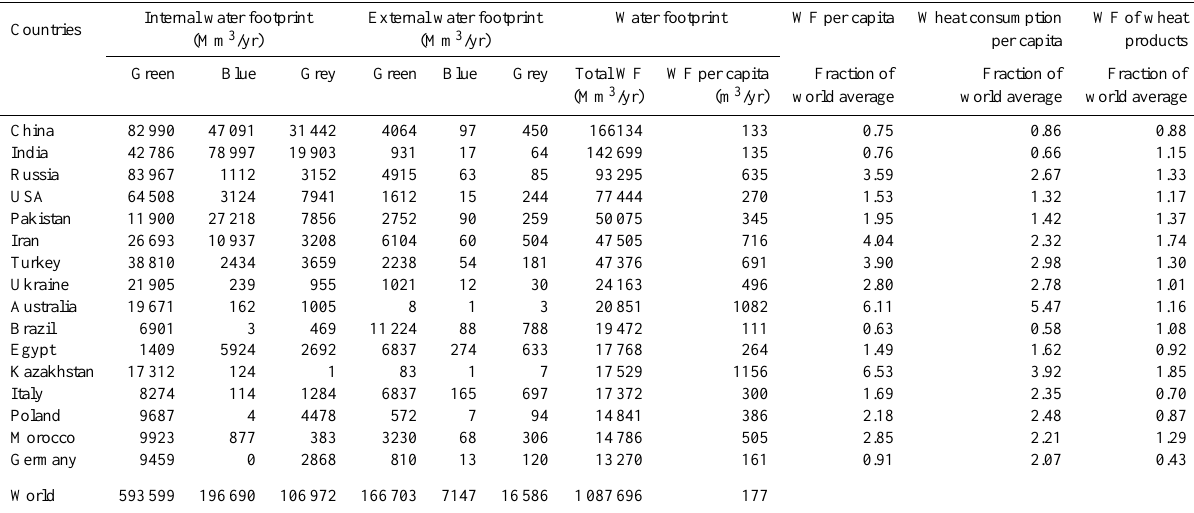
Table 5. Water footprint of wheat consumption for the major wheat consuming countries